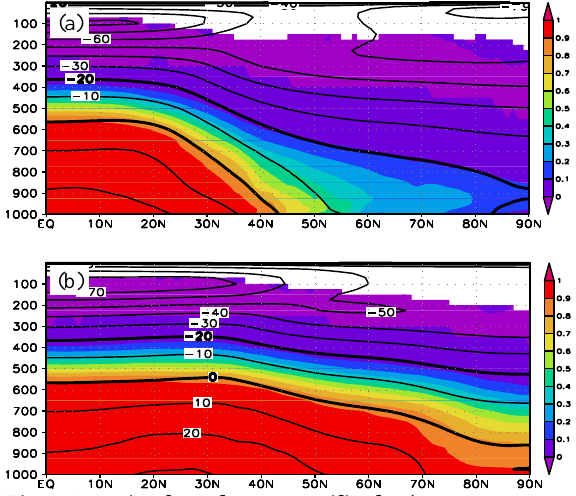
(Figure 3, contour), the latitude dependent fitting accords well and high